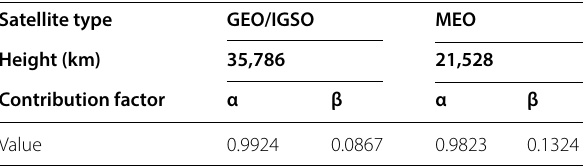
Table 1 Average contribution factors of satellites on SISRE (elevation mask angle: 5°) Satellite type GEO/IGSO MEO Height (km) Contribution